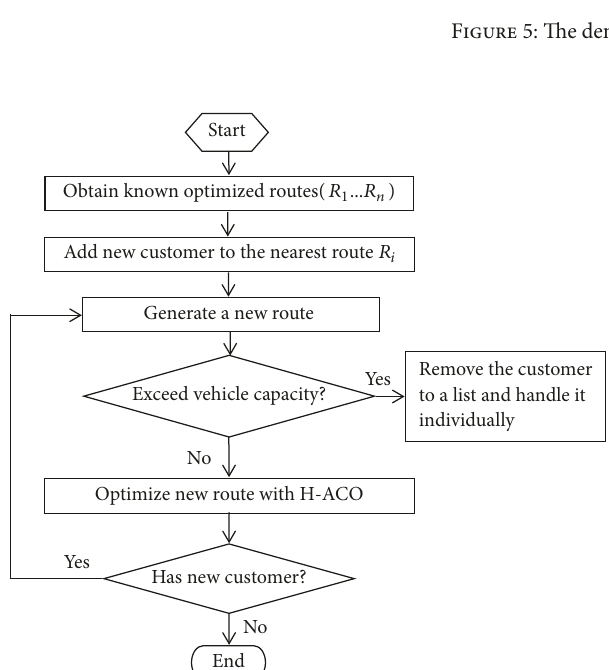
Figure 6: The flowchart of real-time addition and optimization approach.